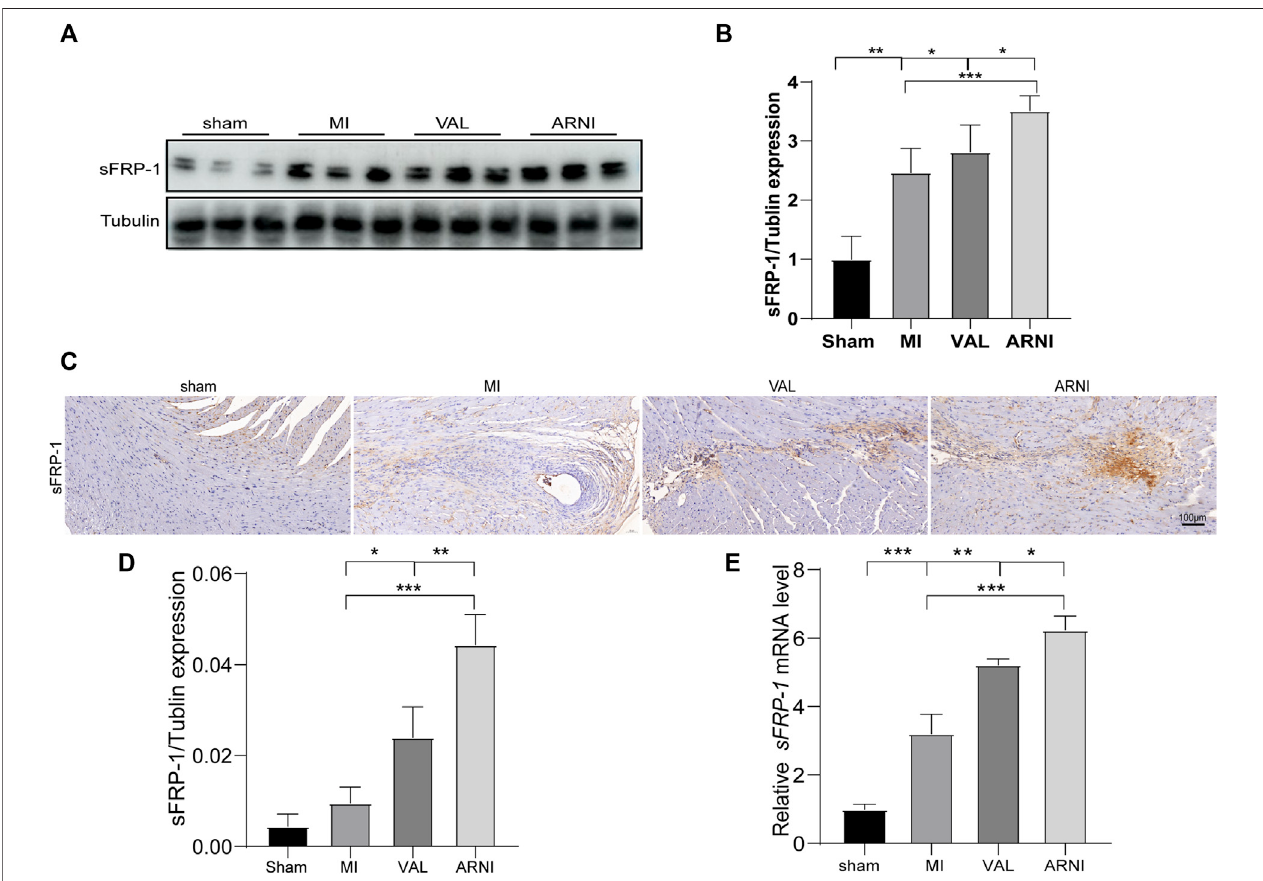
FIGURE 5 | The expression of sFRP-1 after ARNI and VAL intervention. (A,B) Western blot analysis of the expression of sFRP-1. (C,D) Immunohistochemistry staining of sFRP-1. (E) Relative mRNA expression level of sFRP-1. Each group n (cid:1) 7.* p < 0.01,** p < 0.05, *** p < 0.001.